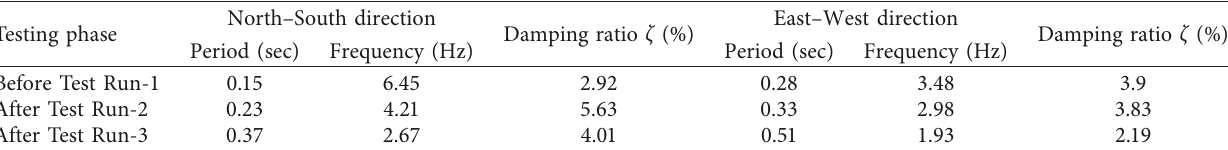
Figure 17: Hysteretic behavior of structure at each test run. (a) Run-1 global hysteretic response at 3.12 Hz. (b) Test Run-1 second-storey hysteretic response at 3.12Hz. (c) Test Run-1 first-storey hysteretic response at 3.12 Hz. (d) Global hysteretic response at 5.16Hz. (e) Run-2 second-storey hysteretic response at 5.16Hz. (f) Test Run-2 first-storey hysteretic response at 5.16Hz. (g) Run-3 Global hysteretic response at 4.16Hz. (h) Run-3 second-storey hysteretic response at 4.16Hz. (i) Test Run-3 first-storey hysteretic response at 4.16Hz. Table 6: Summary of dynamic identification tests.